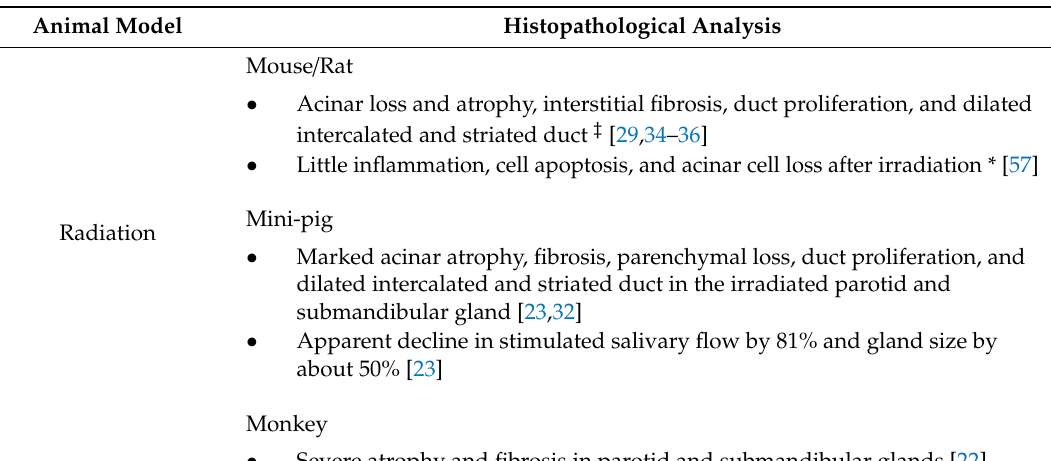
Table 4. Histopathological change in animal model system of salivary gland